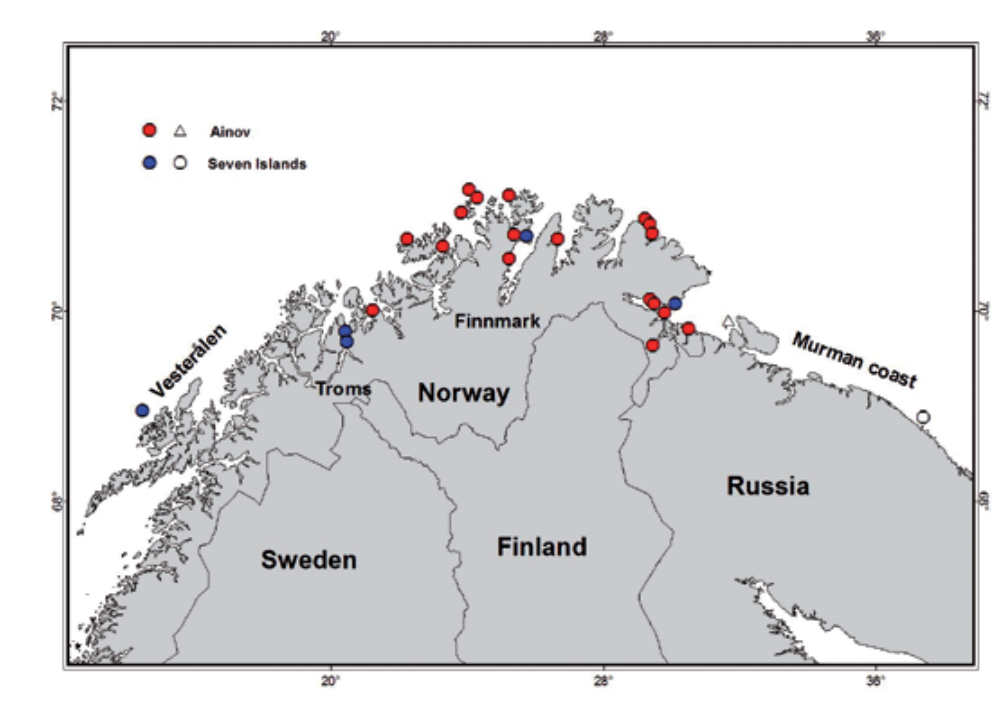
Fig. 1. Grey seal tag